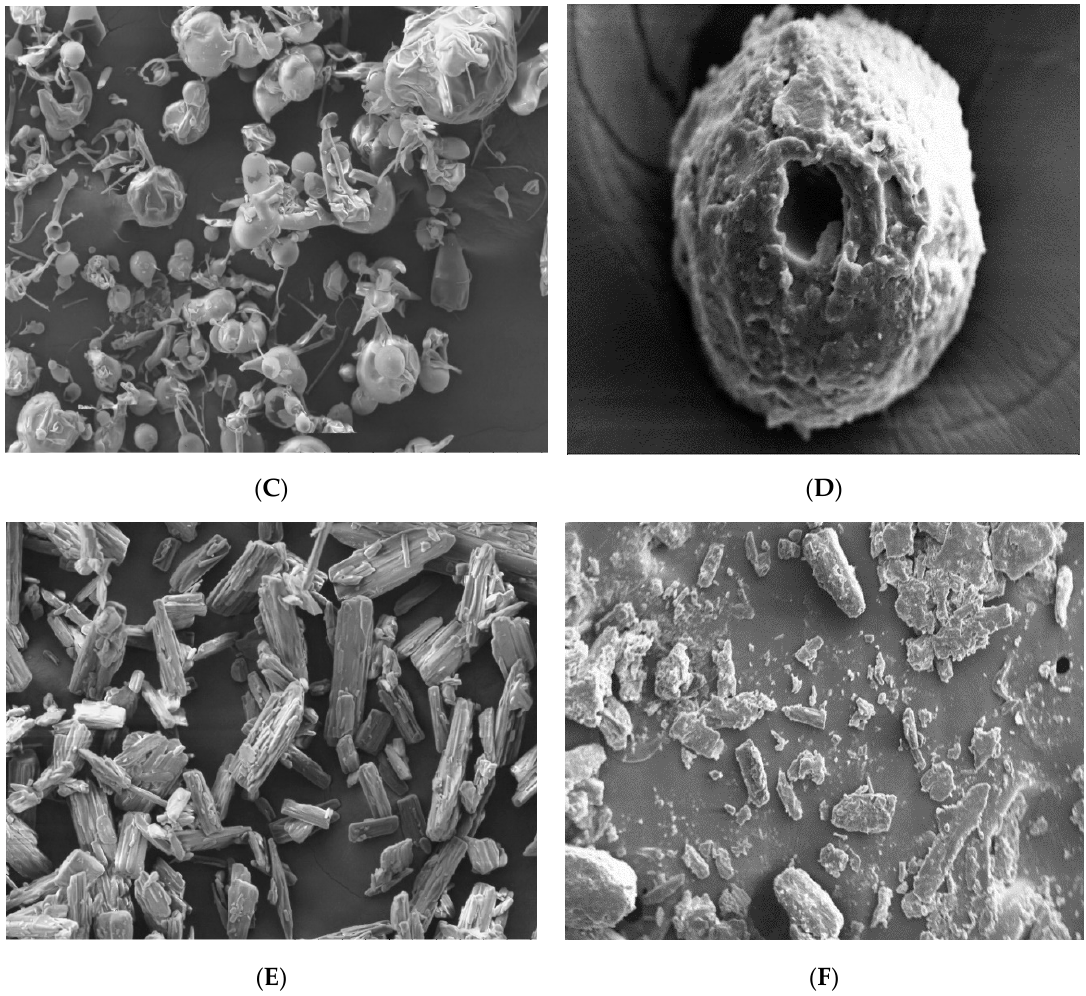
Figure 4. Scanning Electron Microscopy SEM Images of ( A ) pure glucose carrier, Magnification (Mag) = 250 X, ( B ) glucose ptoniosomes FN1, Mag = 500 X, and ( C ) Pure maltodextrin, Mag = 250 X, ( D ) maltodextrin proniosomes, FN2, Mag = 445 X, ( E ) pure mannitol carrier, Mag = 250 X, ( F ) mannitol proniosomes, FN3, Mag = 100 X.